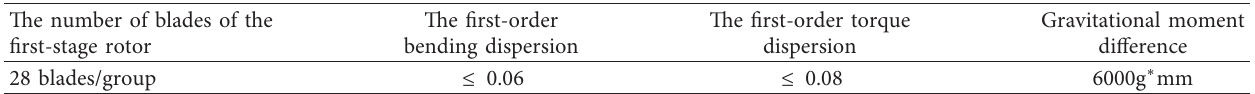
Table 2: The selection rules of the first-stage rotor